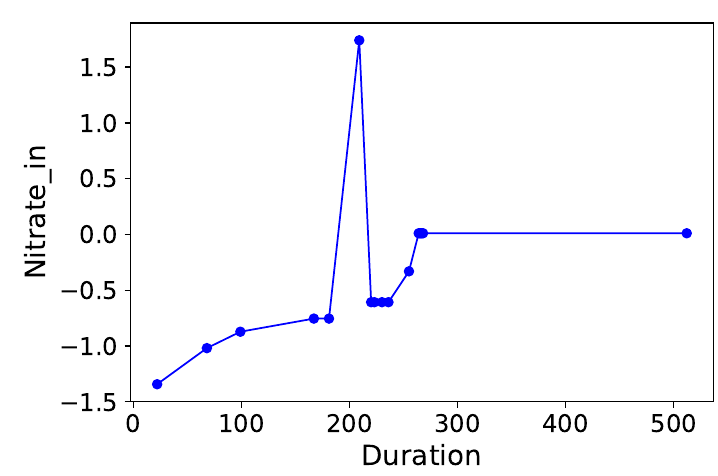
Figure A17. Normalized nitrate inlet flowrate for Reactor